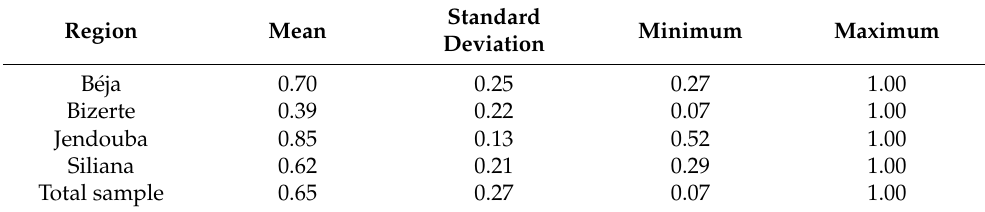
Table 2. Summary statistics for technical efficiency scores. Region Mean